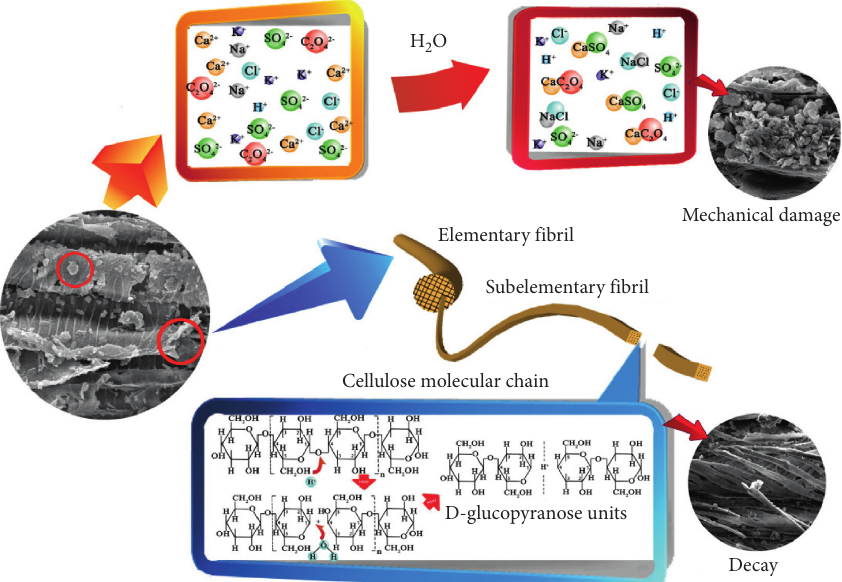
Figure 9: Unusual corrosion mechanism in aged wood. The arrows indicate two corrosion routes: the hydrolysis of carbohydrates due to acidogenic substances from the atmosphere and the mechanical damage of the cell structure due to salt